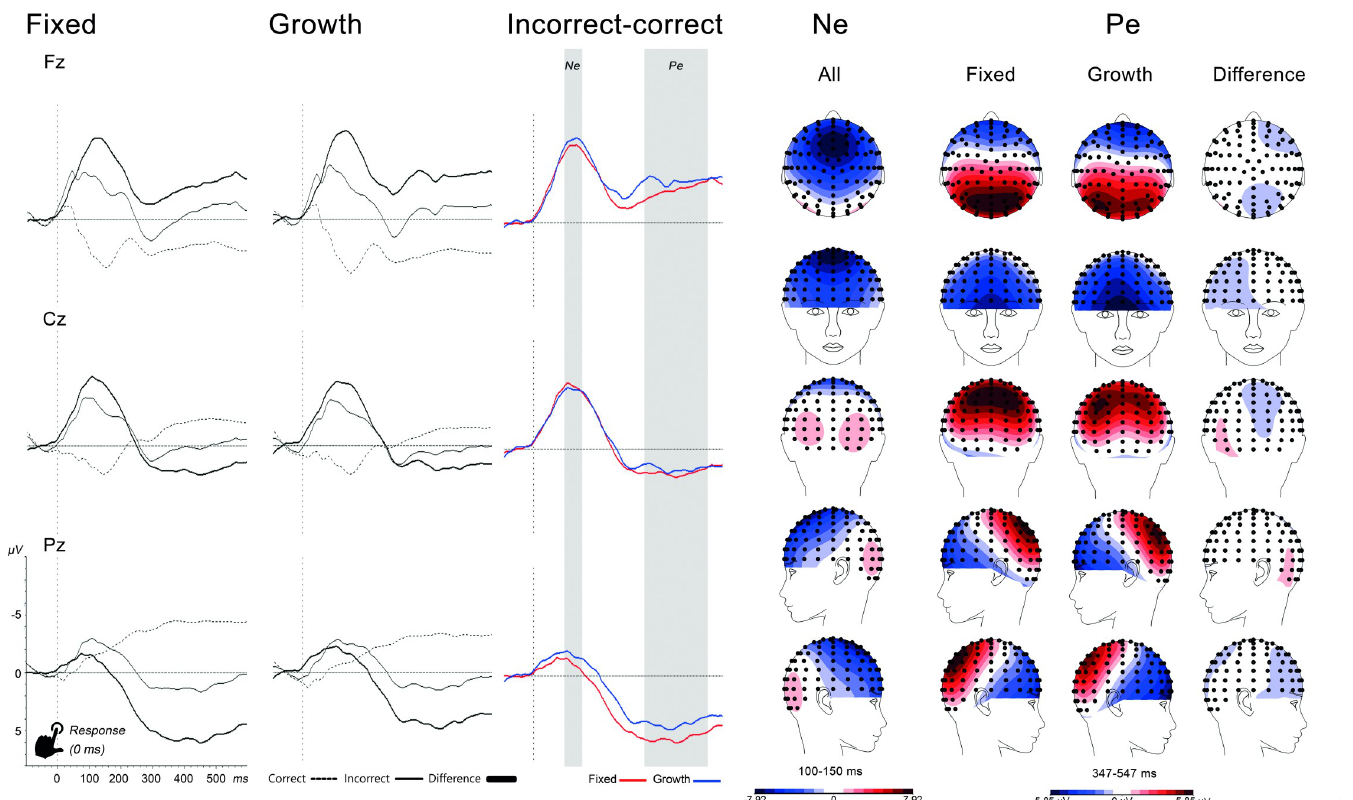
Fig 5. Response-locked ERPs for correct, incorrect and difference ERPs corrected for stimulus overlap with ADJAR. Note . For display purposes, a median split was used to show fixed and mindset ERPs and Pe topographic maps. Gray areas are the Ne and Pe analysis windows.